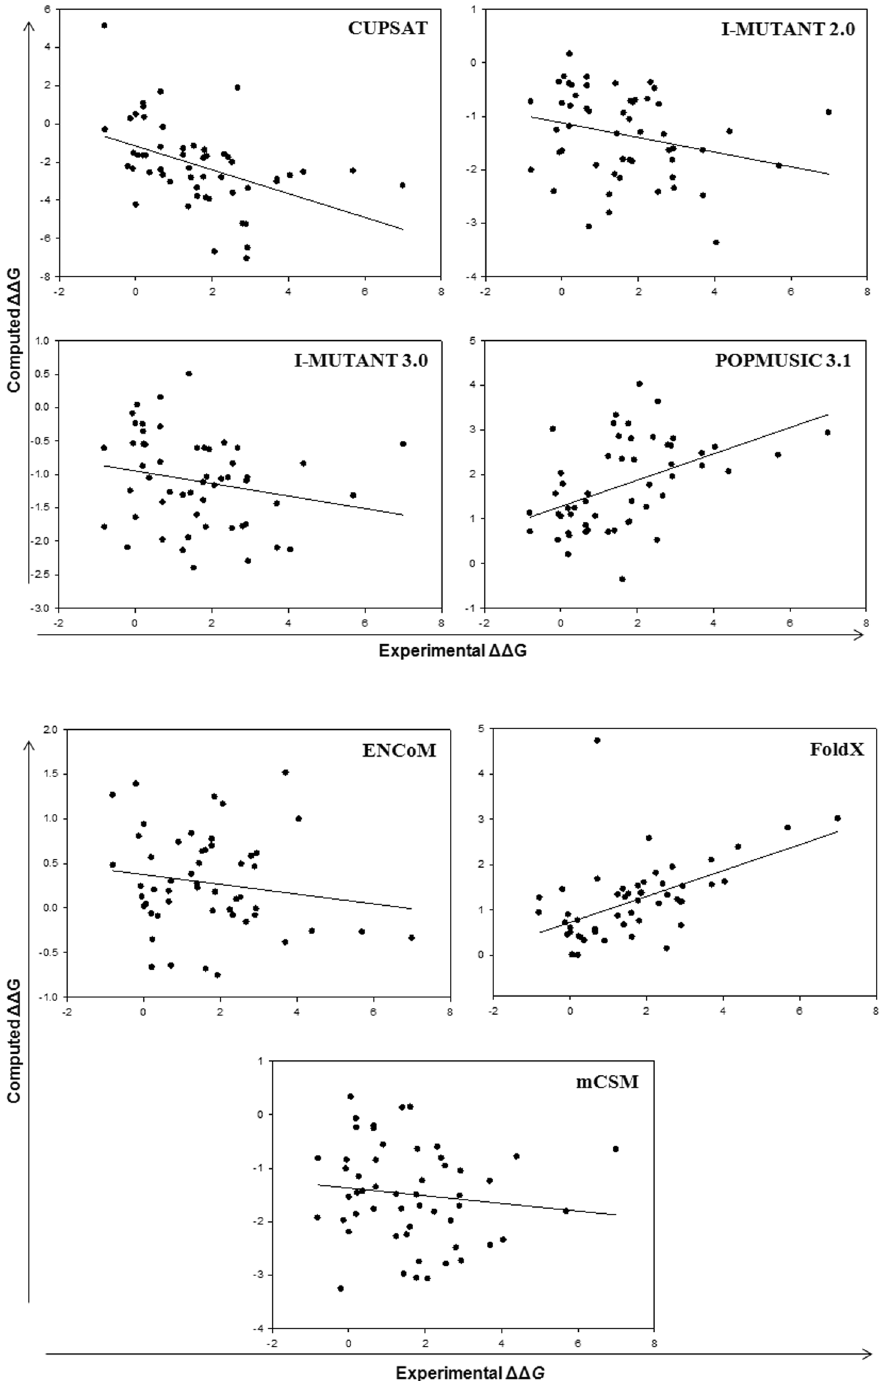
Figure 2. Correlation between experimental monomer and computed stability changes, ΔΔ G (kcal/mol) for 54 mutants using 2XJK and eight methods. (Data for other structures has been shown in Supporting